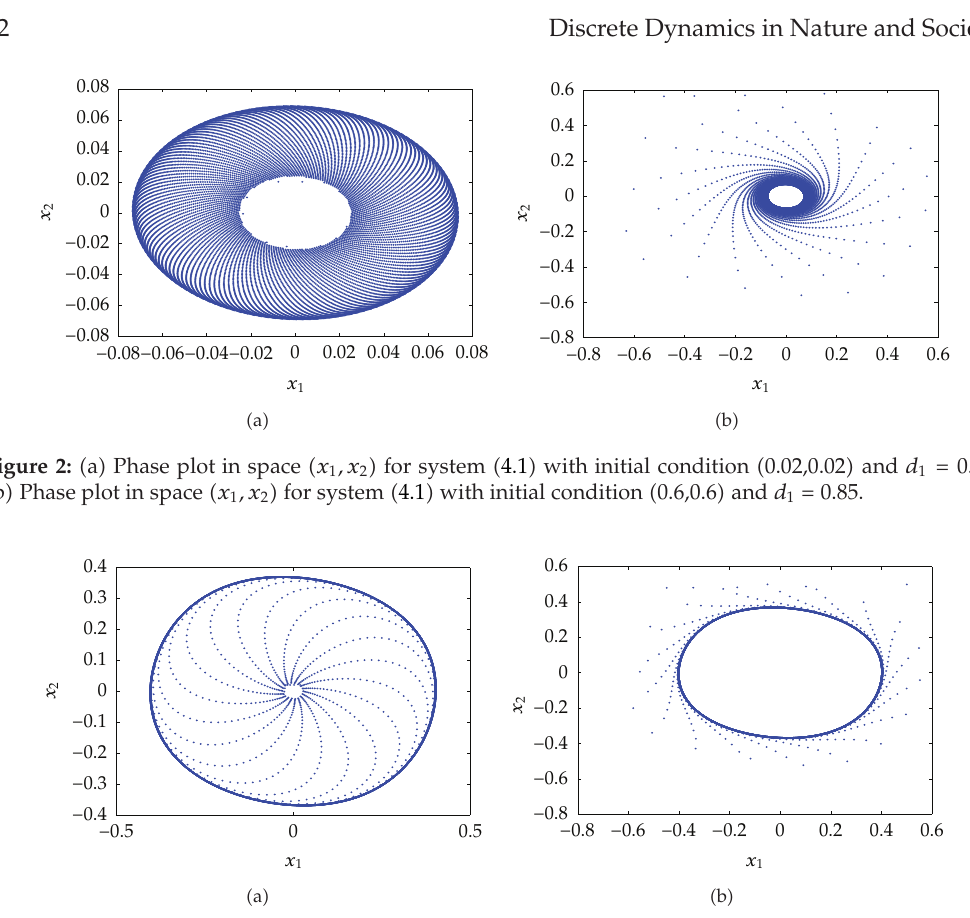
Figure 3: Bifurcation diagram in (cid:4) d 1 ,x 1 (cid:6) -plane for system (cid:4) 4.1 (cid:6) with step size of 0.01 for d 1 and initial condition (cid:4) 0.001,0.001 (cid:6) , in which there are 100 points for each d 1